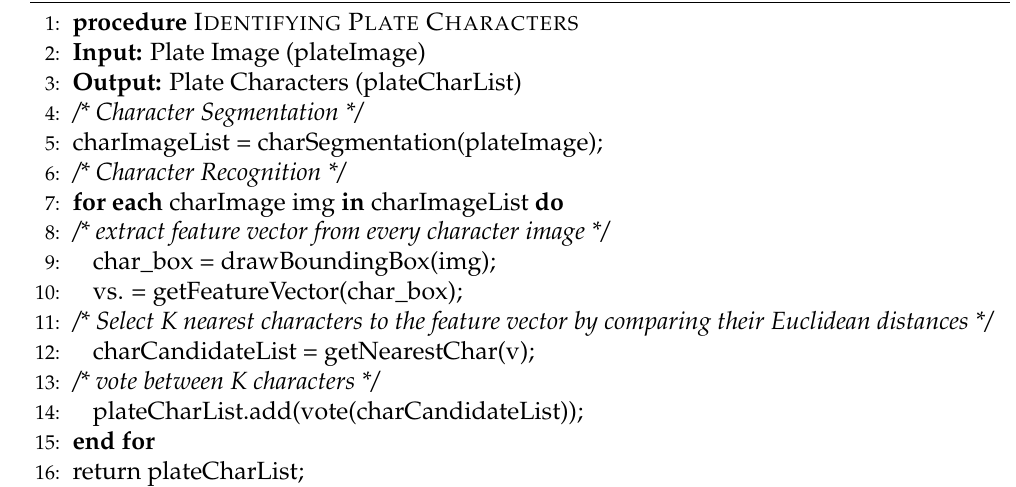
Algorithm 2 Character Segmentation and Recognition